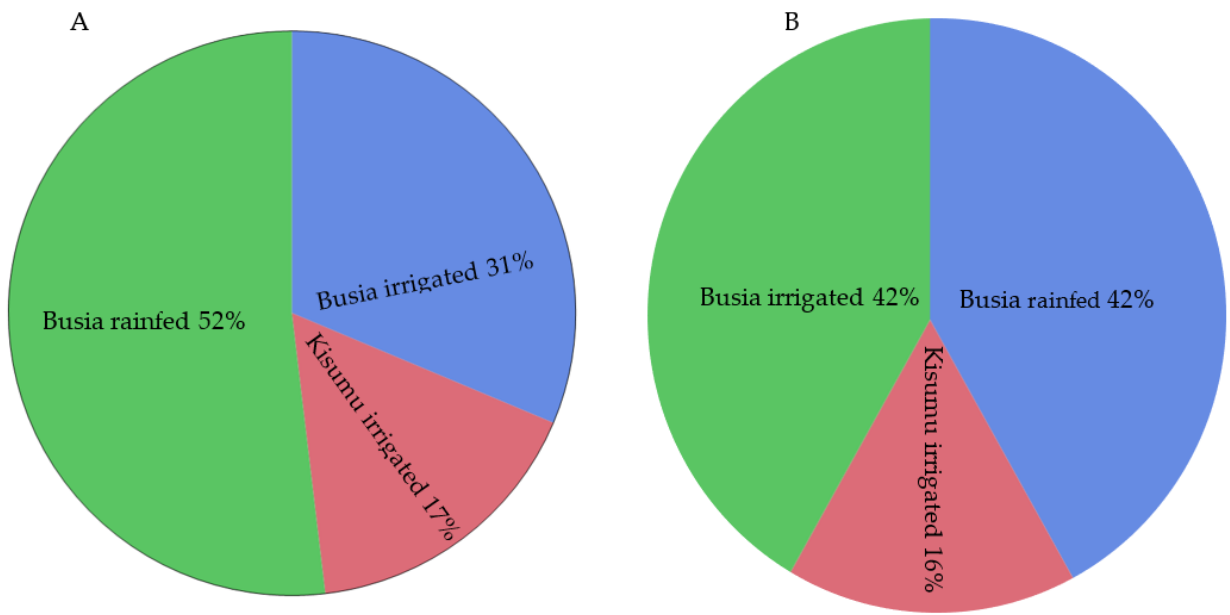
Figure 1. Incidence of blast ( A ) and brown spot ( B ) diseases in rice grown under different production systems in Busia and Kisumu counties of Kenya in 2019.